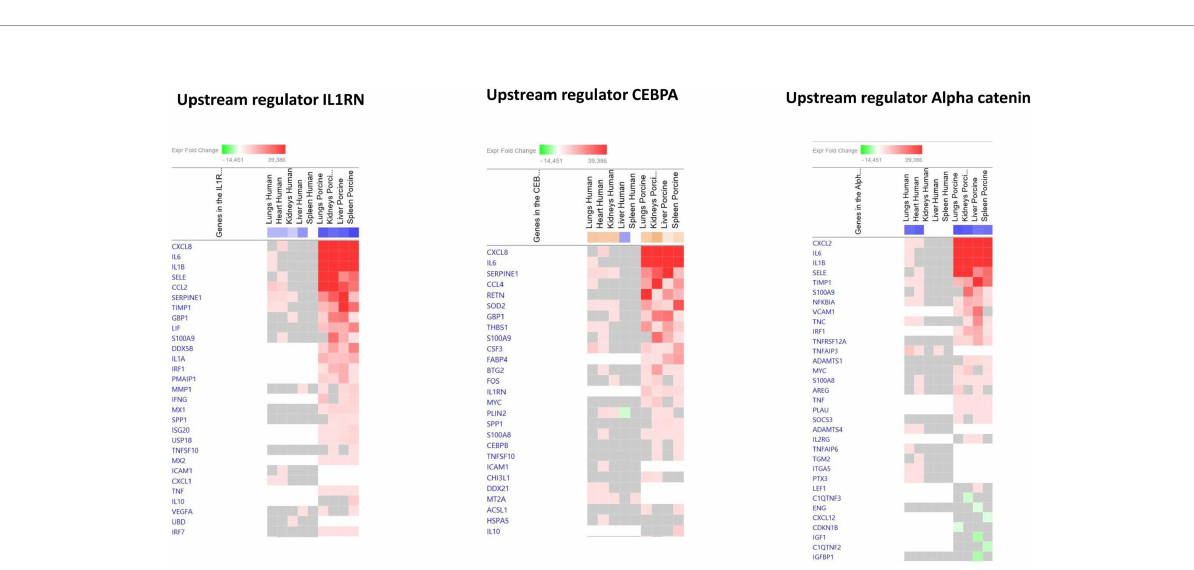
FIGURE 5 Predicted gene signaling pathways from the top downregulated upstream regulators in FFPE tissue samples from patients with meningococcal septic shock and in organs from porcinis infused with exponentially increasing numbers of N. meningitidis (reference strain H44/76) vs. controls. The Z-score indicates predicted activation state of genes in the upstream regulator signaling network. Orange or lighter shades of orange indicate a positive Z-score and upregulation of the upstream regulator signaling network. Blue color or lighter shades of blue indicate a negative Z-score and downregulation of the upstream regulator. The transcripts in the signaling network are expressed as fold change (FC) values. Red or lighter shades of red indicate positive FC-values and upregulation of transcripts; green color or lighter shades of green indicate negative FC- values and downregulation of transcripts. The color gray indicates that a predicted activation state of a gene/transcript in the upstream regulator pathway signaling network is not affected (the gene/transcript was in the dataset but did not pass the analysis cutoffs). White color indicates that gene/transcript are not present in the